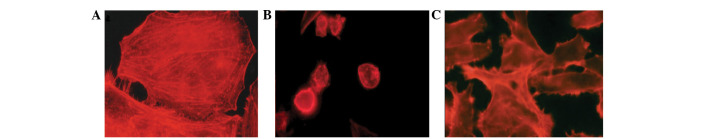
HEp-2 cells labeled with phalloidin-TRITC, 12 h following PDT. (A) The control group, non-irradiated cells with intact cytoskeleton (arrow); (B) the AlPcS4/PDT group, the filaments are concentrated in the cell periphery (arrow), with retraction of the cytoplasm; (C) in the ZnPc/PDT group, the disappearance of stress fibers of actin filaments (arrow) was observed. PDT, photodynamic therapy; AlPcS4, aluminum phthalocyanine tetrasulfonated; ZnPc, zinc phthalocyanine.